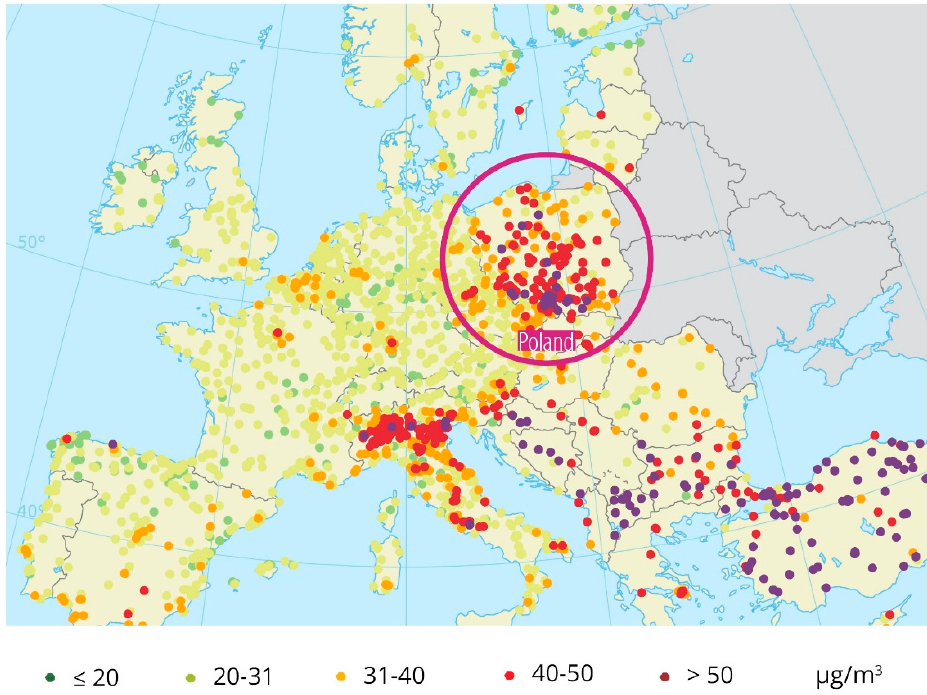
Figure 2. Concentration of PM10 in Poland and Europe in 2016 (based on Reference [28]).